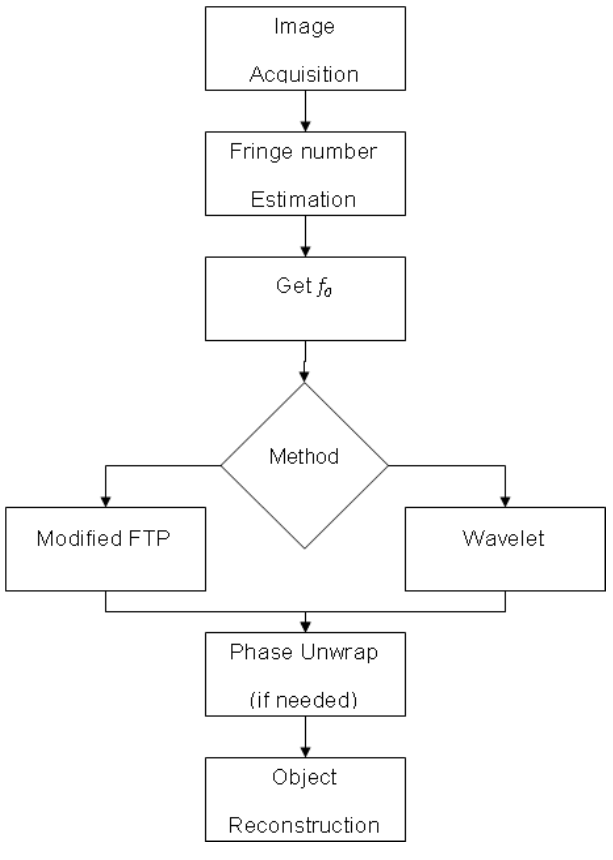
Figure 3. Proposed